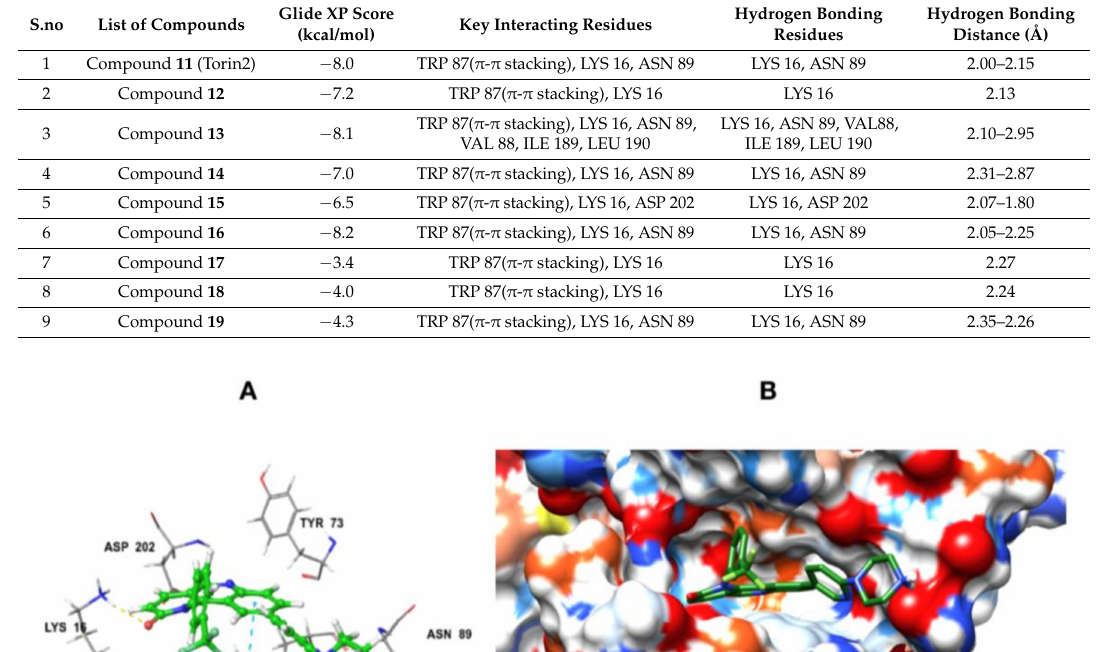
Table 1. Glide docking score and important residues interacting with inhibitors.